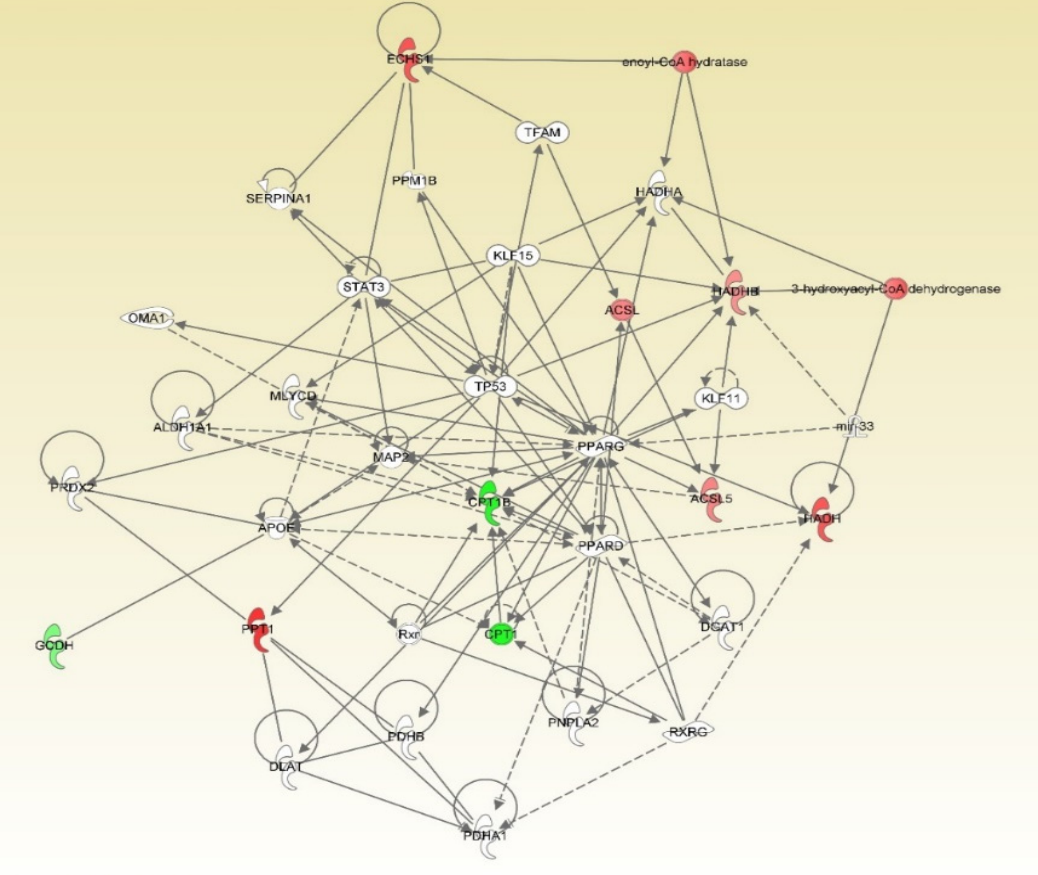
Figure 1. Mechanistic network for the seven fat metabolism genes. The network was generated through the use of ingenuity pathways analysis (IPA) (QIAGEN Inc.,